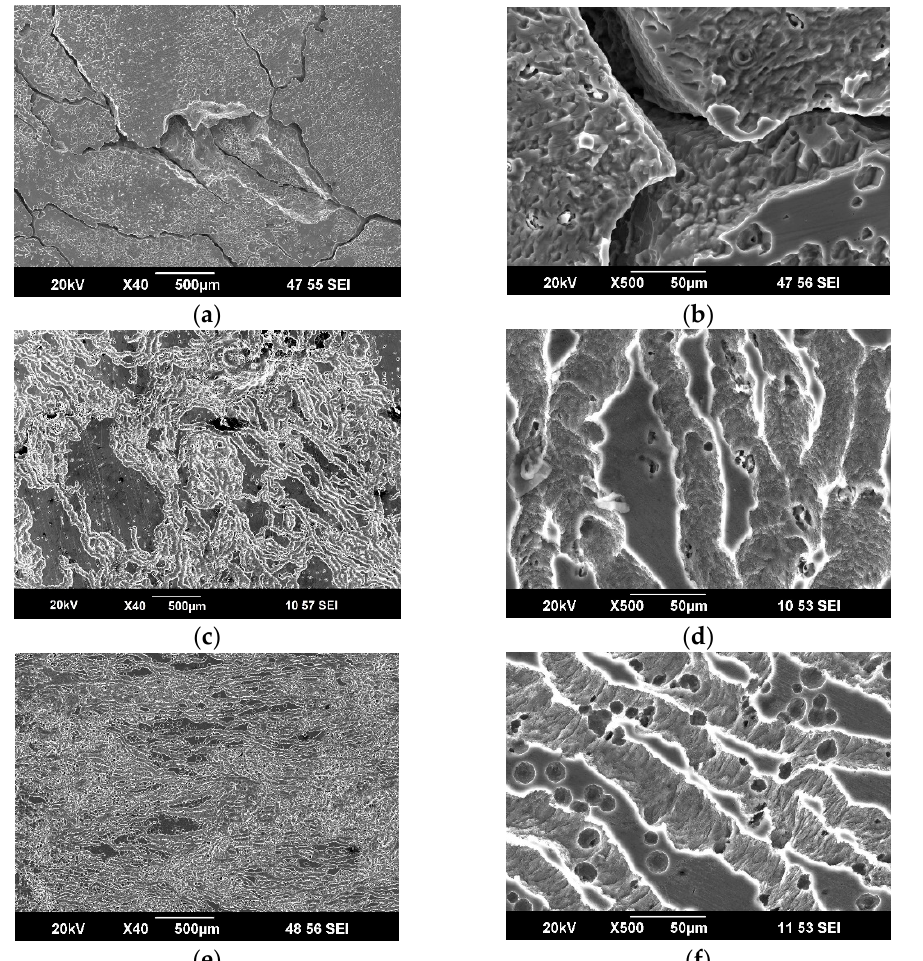
Figure 5. Surface structure of the Mg-1%Ca alloy samples: ( a , b ) in the homogenized state, ( c , d ) after HPT, ( e , f ) after HPT and additional HT at 250 °C, after 1 day of exposure in Ringer’s solution.